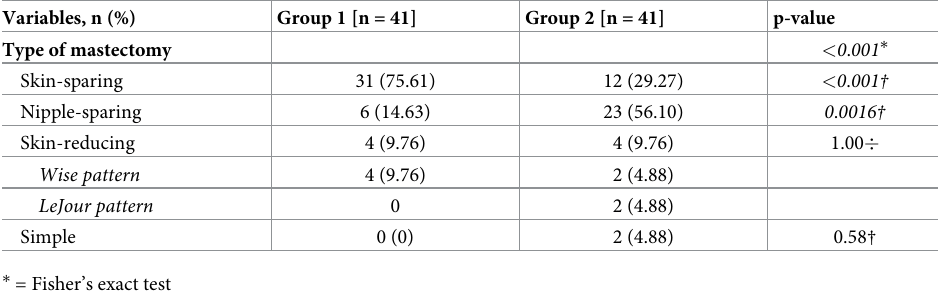
Table 2. Summary of bilateral risk-reducing mastectomy procedures performed throughout the study